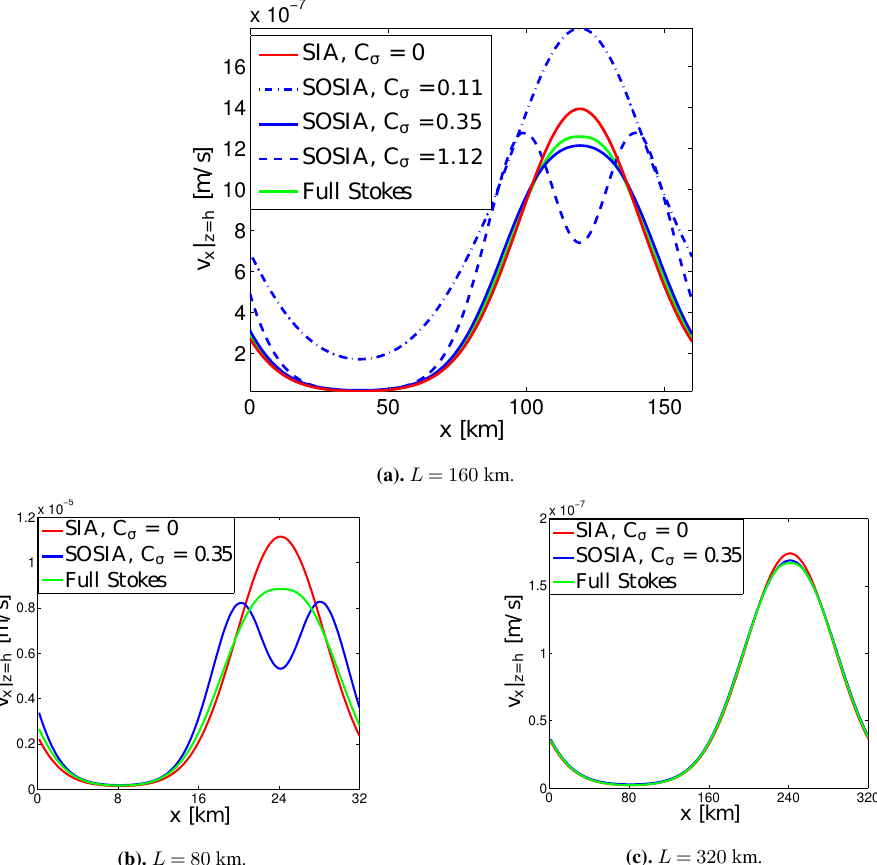
Fig. 3. Surface x velocity for the full Stokes solution, the SIA and the SOSIA. For SOSIA, σ res = C σ ρg [ H ] (cid:15) is used as a lower threshold for the effective stress.